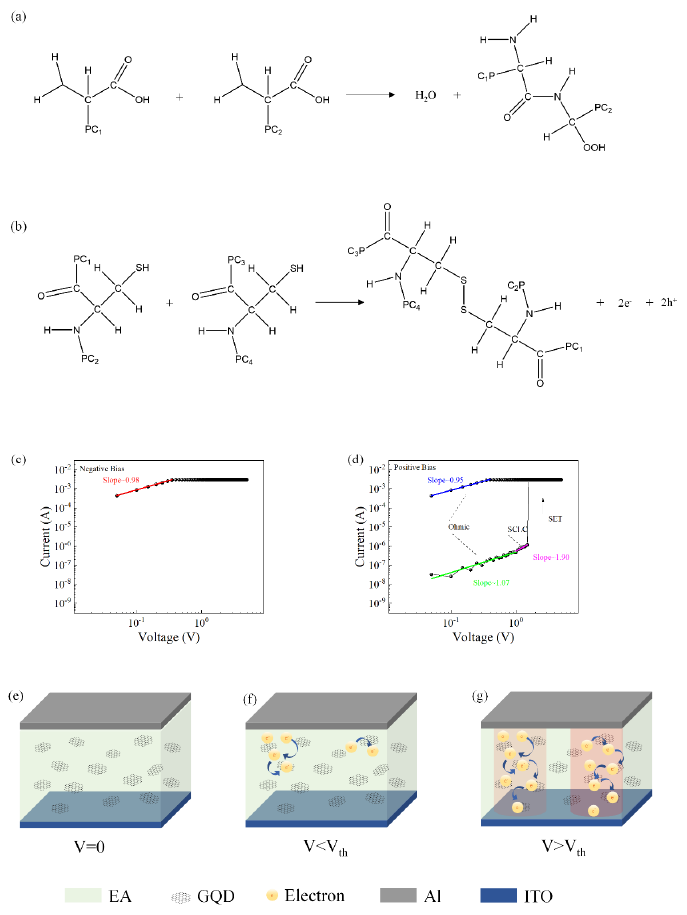
Figure 6. ( a ) Peptide bond formation process. ( b ) Disulfide bond formation process I–V curves of the device Al/EA:GQD/ITO/PET redrawn in double logarithmic coordinates. ( c ) Initially applied negative voltage. ( d ) Diagram of the conduction mechanism of the device with an initial positive voltage applied. ( e – g ) Diagram of the conduction mechanism.